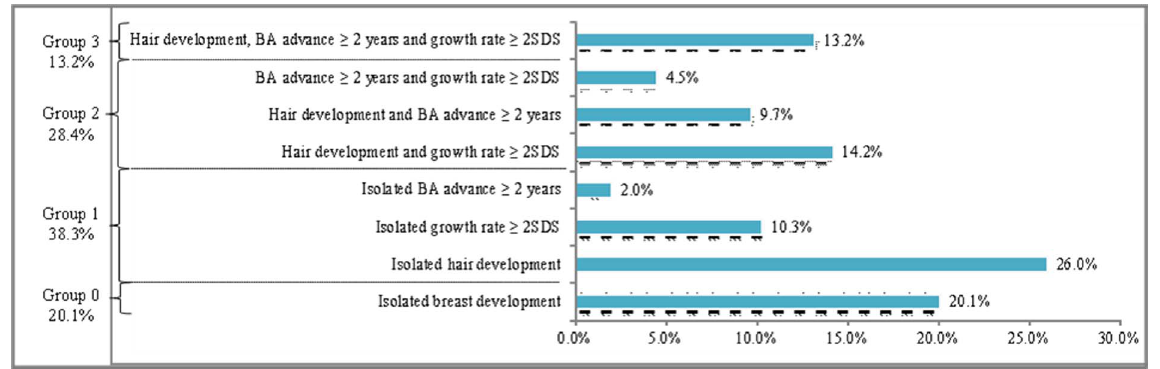
Figure 1. Distribution of the 493 girls with idiopathic CPP classified according to the number of the signs of puberty associated with breast development.